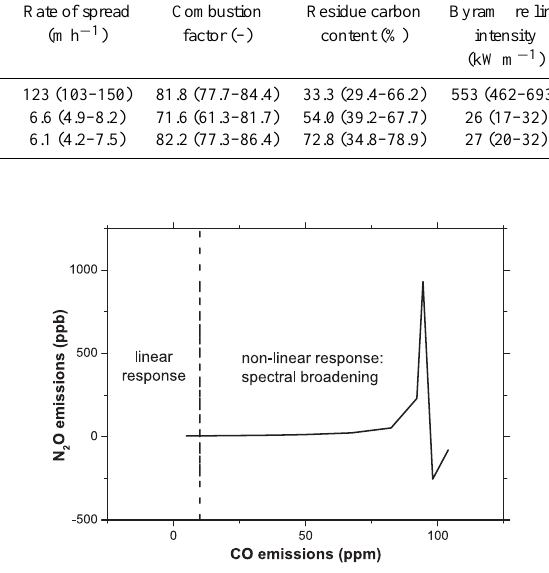
Figure 3. A graph of the interaction between N 2 O and CO emis- sions measurements during routine calibrations which necessitated the use of a dilution